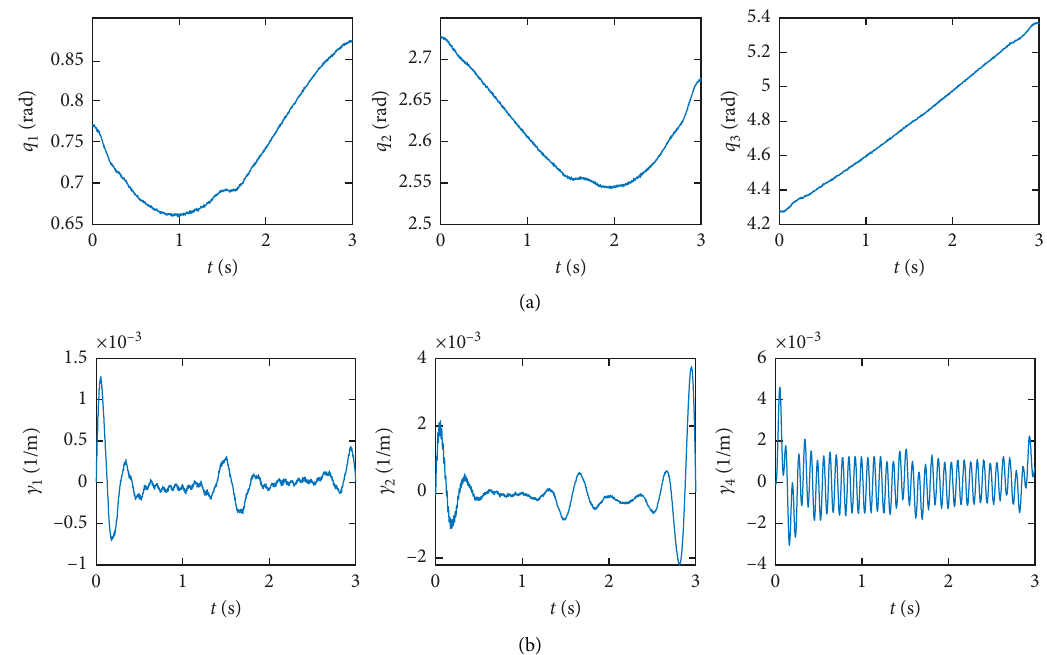
Figure 5: Measured outputs: angular positions of the actuated links (a); curvatures of links 1, 2, and 4 (b).